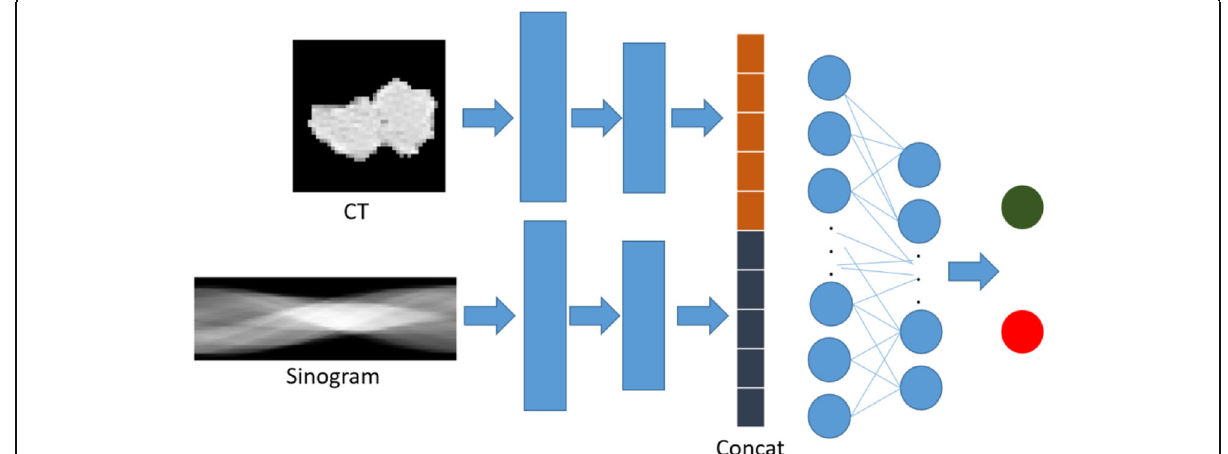
Fig. 7 Workflow of our proposed scheme with combined inputs from image domain and sinogram